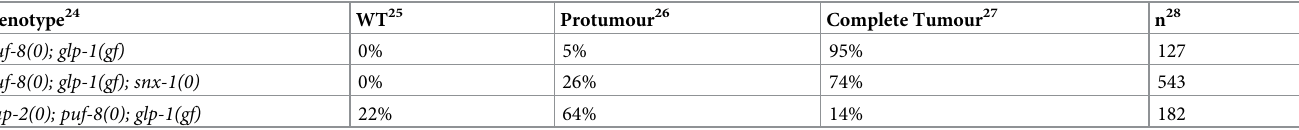
Table 5. Loss of snx-1 weakly suppresses